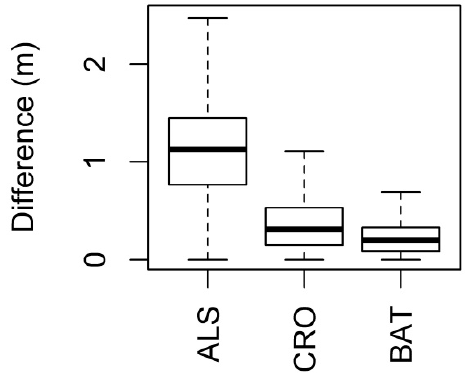
Figure 6. Variance of raster cell differences among compared digital elevation models.